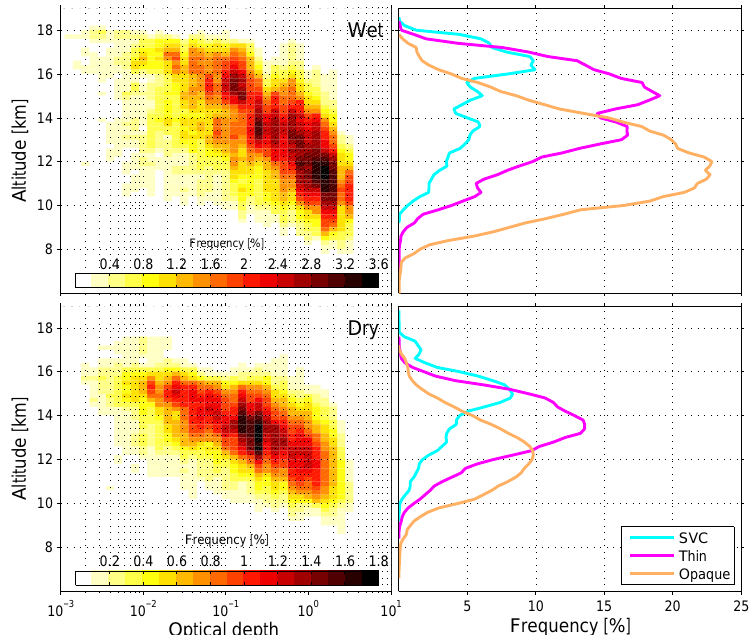
Figure 6. Two-dimensional histograms of cirrus frequency of occurrence with altitude as a function of optical depth during the wet (top) and dry (bottom) season months are shown on the left. The same is shown on the right but integrated for SVC, thin, and opaque cirrus cloud optical